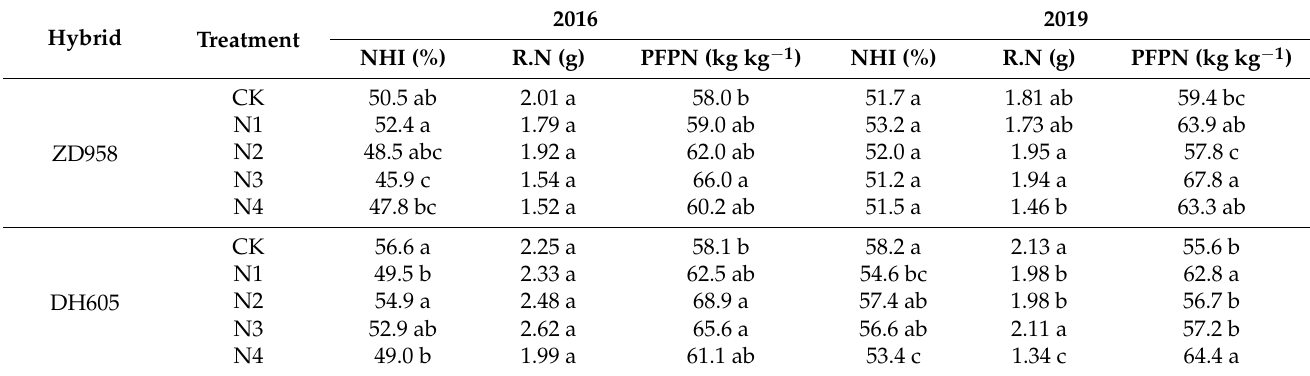
Table 4. Effects of N treatments on N harvest index, remobilized N, and N fertilizer partial productivity. Hybrid